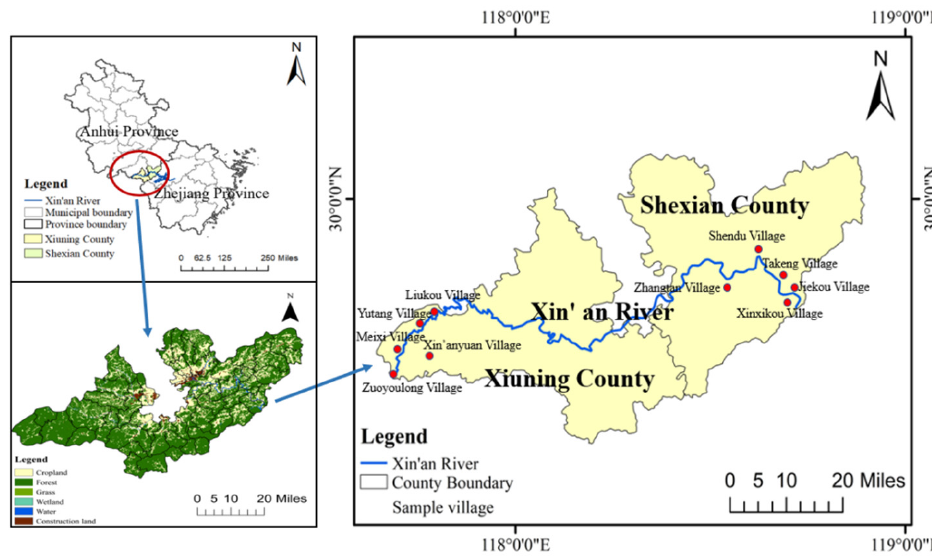
Figure 1. Location of Xin’an River.